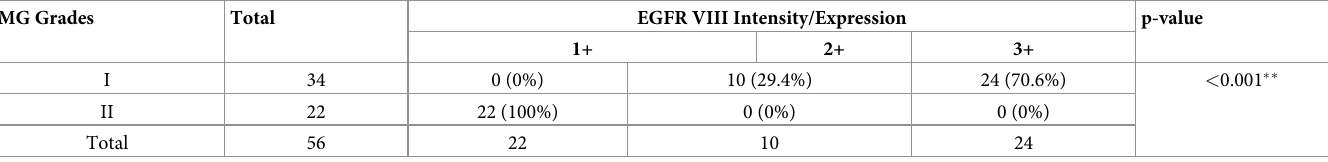
Table 3. EGFR vIII staining intensity/expression of meningioma samples (grade I and II), n (%). MG Grades